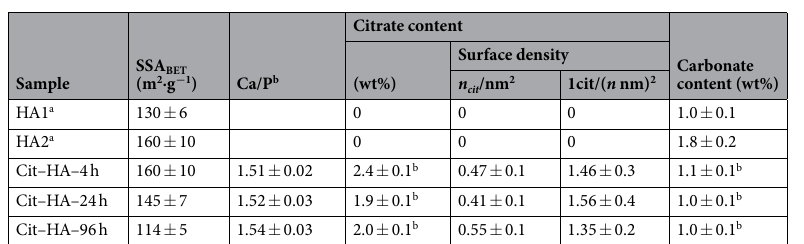
Figure 2. HR-TEM images of border regions of ( a ) Cit-HA-4 h, ( b ) Cit-HA-24 h and ( c ) Cit-HA-96 h. Interfringes spaces within the arrows are 0.814 nm in a and c , corresponding to d 0.229 nm in b , corresponding to d {0003} = 0.2294 nm. Original magnification: 400k × . Insets: FT of the image portions enframed within the white squares. As indicated in the insets, particles were observed along the following directions (zone axes): ( a ) [1216] ( a -axis in the image plane, c -axis forming an angle of ∼ 55° below the image plane); ( c ) [1210] , i.e. the b -axis ( c- axis in the image plane, a -axis forming an angle of 30° below the image plane).